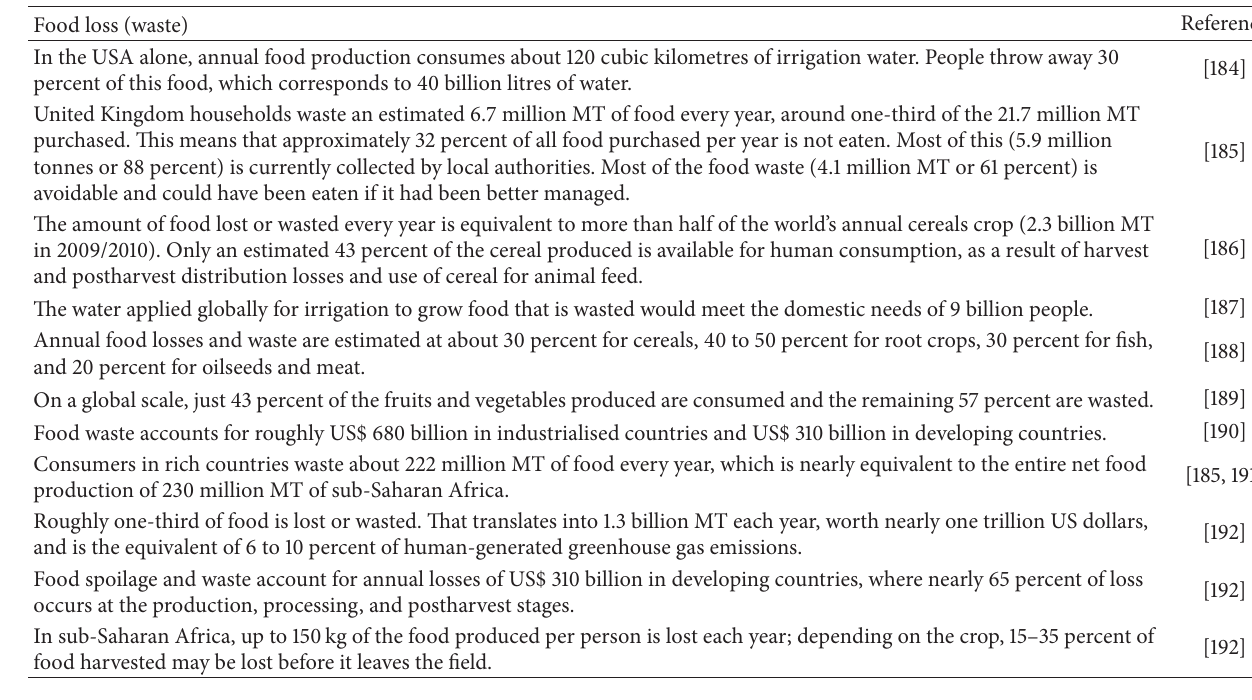
Table 1: Representative global examples of food loss (waste)